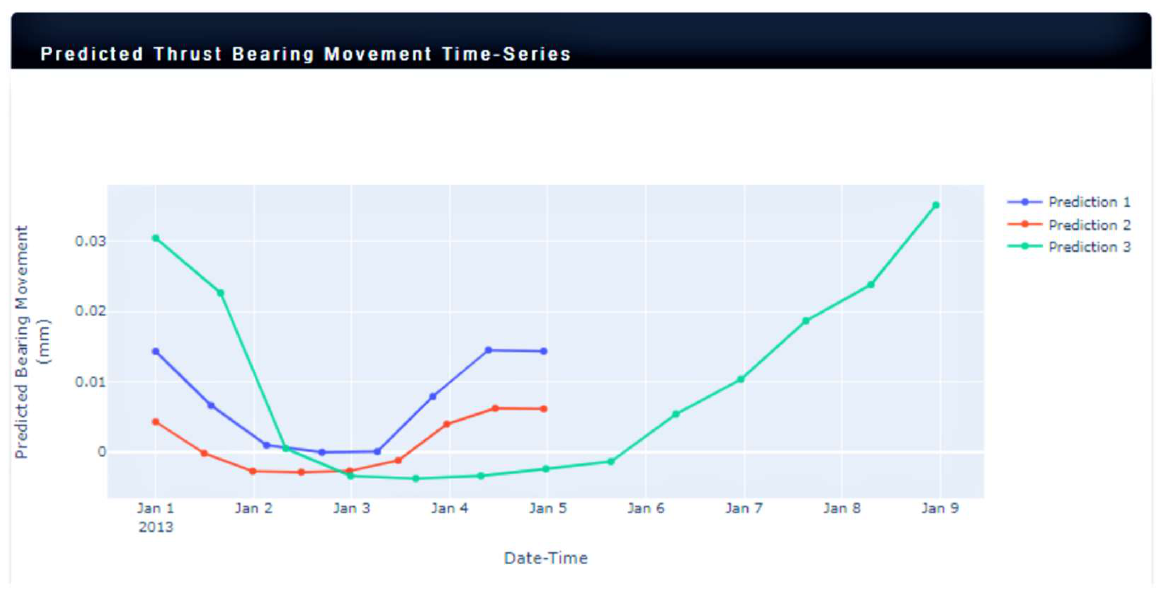
Figure 13. The user interface used to drive operational consequence decision support tool: operational consequence model predicts thrust bearing movement time series for a particular operating sequence.